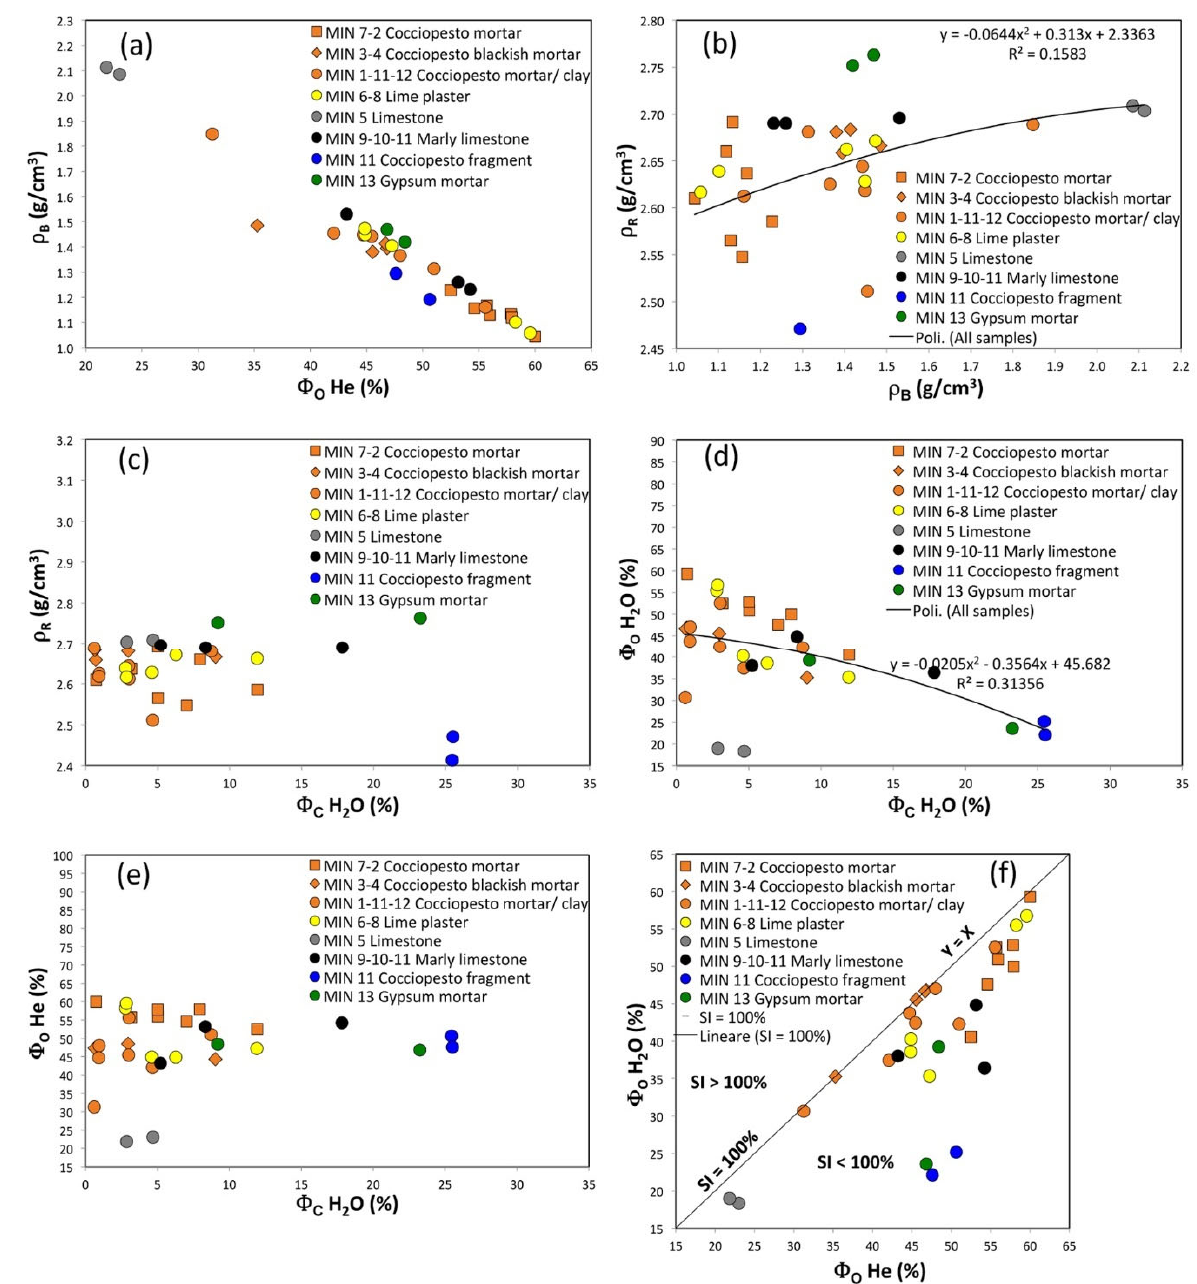
Figure 13. Binary charts which plot the main physical properties of samples taken from Area B and house-fort of Cap de Forma archaeological site. ( a ) helium open porosity ( Φ O He) vs. bulk density ( ρ B ); ( b ) bulk density ( ρ B ) vs. real density ( ρ R ); ( c ) water closed porosity ( Φ C H 2 O) vs. real density ( ρ R ); ( d ) water closed porosity ( Φ C H 2 O) vs.—water open porosity ( Φ O H 2 O); ( e ) water closed